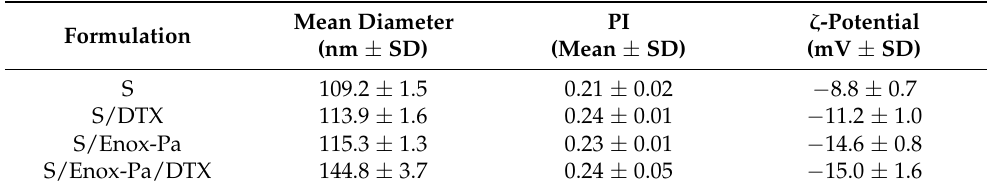
Table 1. Size (nm), PI, and ζ potential (mV) of SEDDS formulations in PBS (20 mM, pH 7.4). Values are reported as mean ±